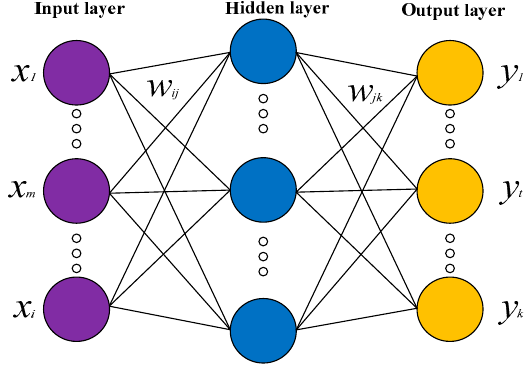
Figure 4. Perceptron network.